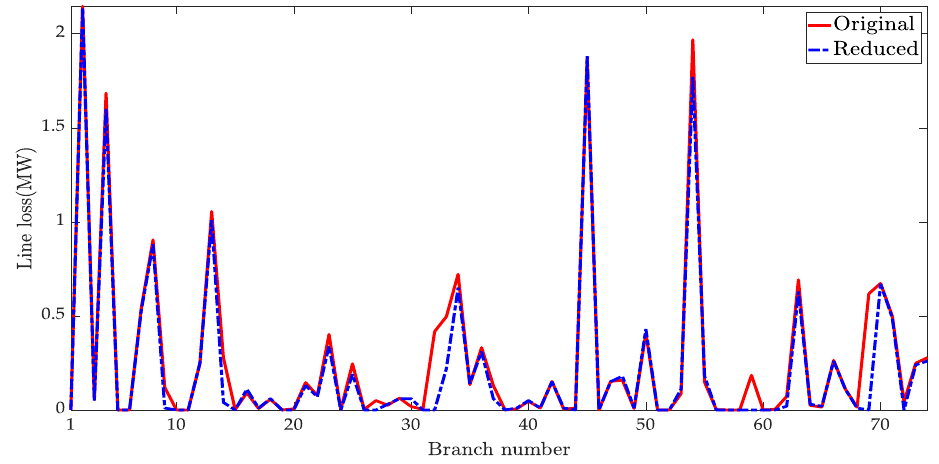
Figure 10. Real power losses of transmission lines.